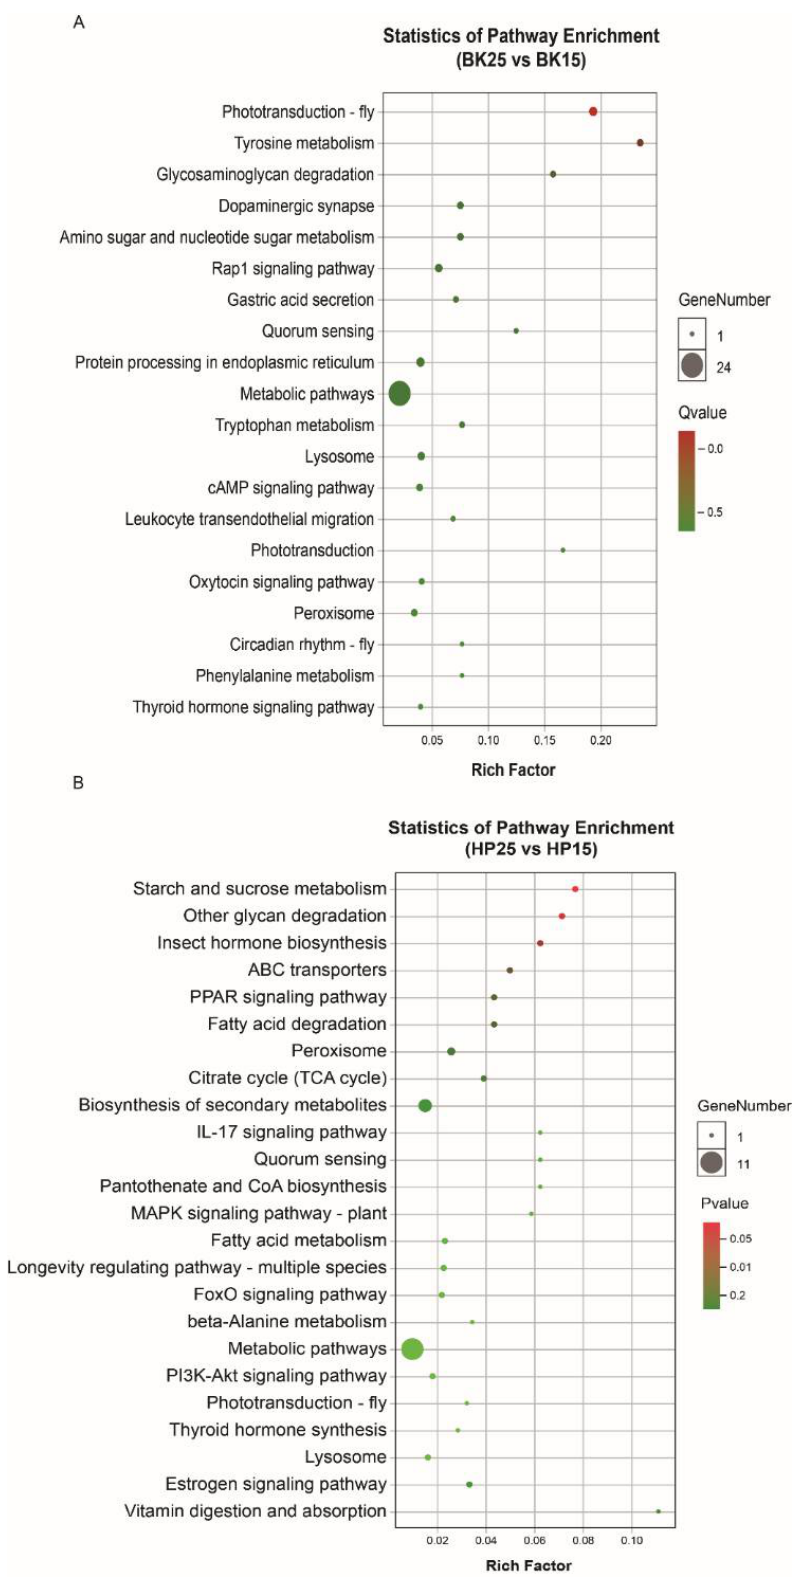
Figure 4. Kyoto Encyclopedia of Genes and Genomes (KEGG) enrichment of DECT genes. ( A ) KEGG pathway enrichment of DECT genes in BK, ( B ) KEGG pathway enrichment of DECT genes in HP. Larger circles indicate more candidate target genes enriched in this pathway, and a q-value/ p -value closer to 0 represents more significant enrichment.